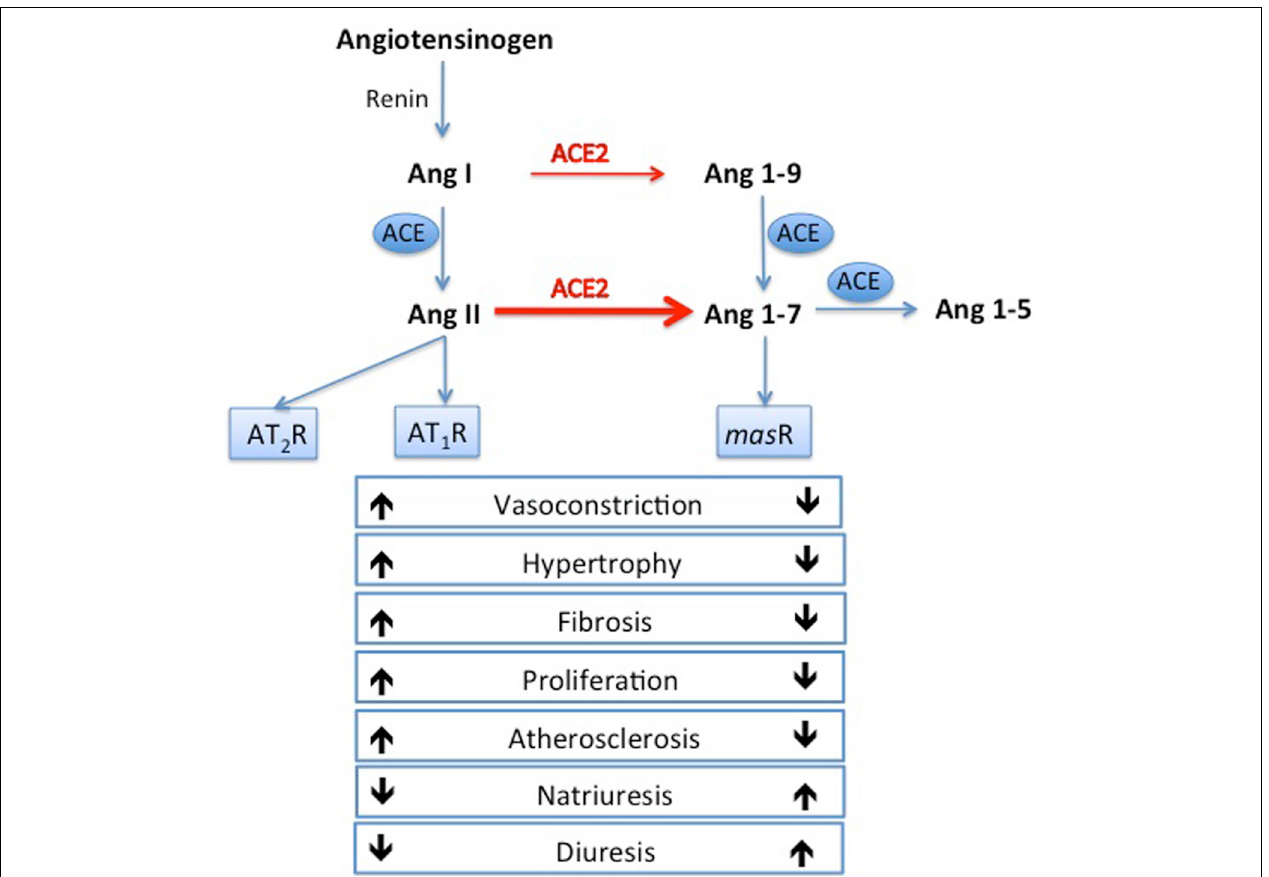
also act on the angiotensin type 2 receptor (AT 2 R) which can counteract AT 1 R mediated effects. In the opposing arm, ACE2 degrades Ang II to Ang 1-7, which is thought to exert beneficial effect via the mas receptor.